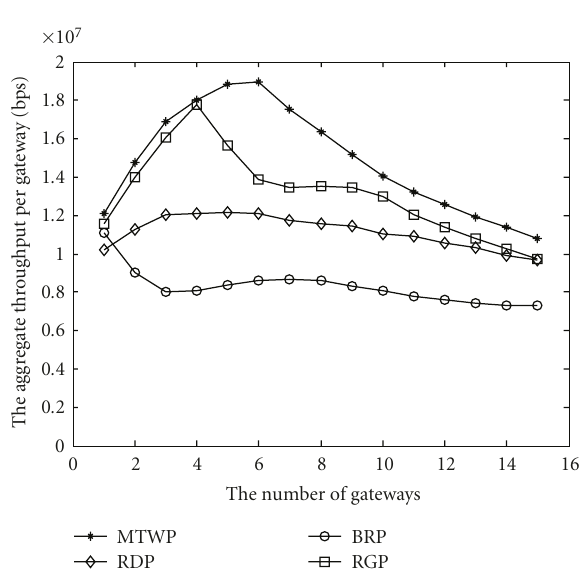
Figure 15: The comparison of the aggregate throughput per gateway with unevenly distributed mesh